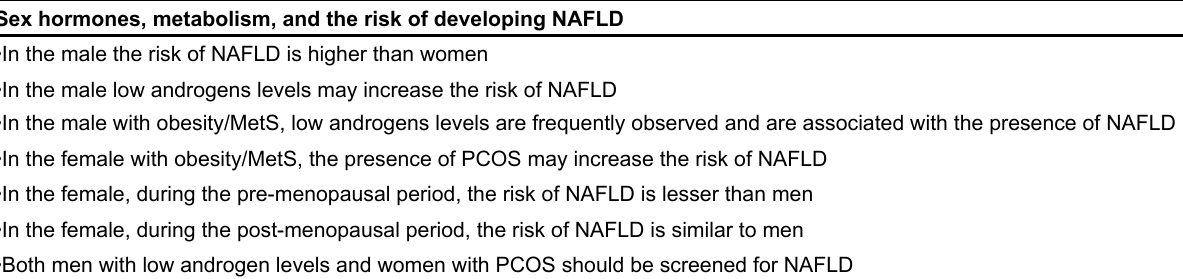
Table 1. Summary of findings about the role of sex hormones in the risk of NAFLD Sex hormones, metabolism, and the risk of developing